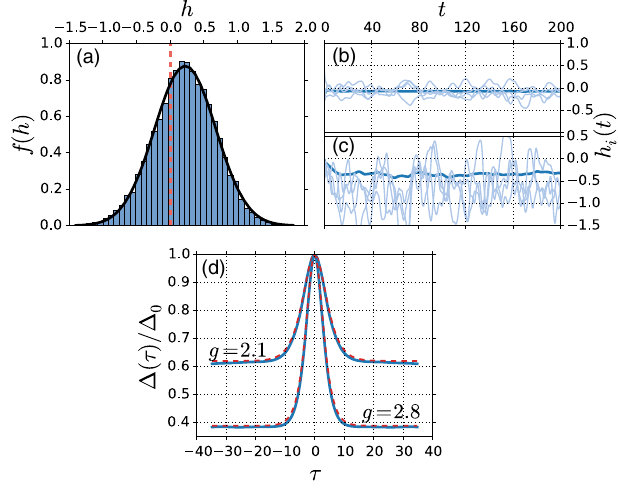
FIG. 4. Numerical simulations of a single population with a linear-threshold transfer function. (a) Distribution of the local fields h i in the fixed-point regime. The thick curve shows normal distribution given the theoretical mean and variance obtained from the mean field theory. The dashed (red) vertical line marks the firing threshold, which is taken to be zero. (b,c) Activities of two networks with gains g ¼ 2 . 1 and g ¼ 2 . 8 , respectively. Bold lines show spatially averaged local fields; thin lines are local fields of a sample of four neurons. (d) The normalized ac function, Δ ð τ Þ = Δ 0 ¼ 1 − q ð τ Þ , for two values of gain parameters as in (b) and (c). Solid black lines are the solutions of the equation of DMFT, Eq. (45), superimposed on simulation results (dashed lines). We show simulations performed on a network ( N ¼ 6800 ) ffiffiffiffi p K g , where with Gaussian-distributed connections and ¯ g ¼ K ¼ 680 and the external field h 0 ¼ 1 .